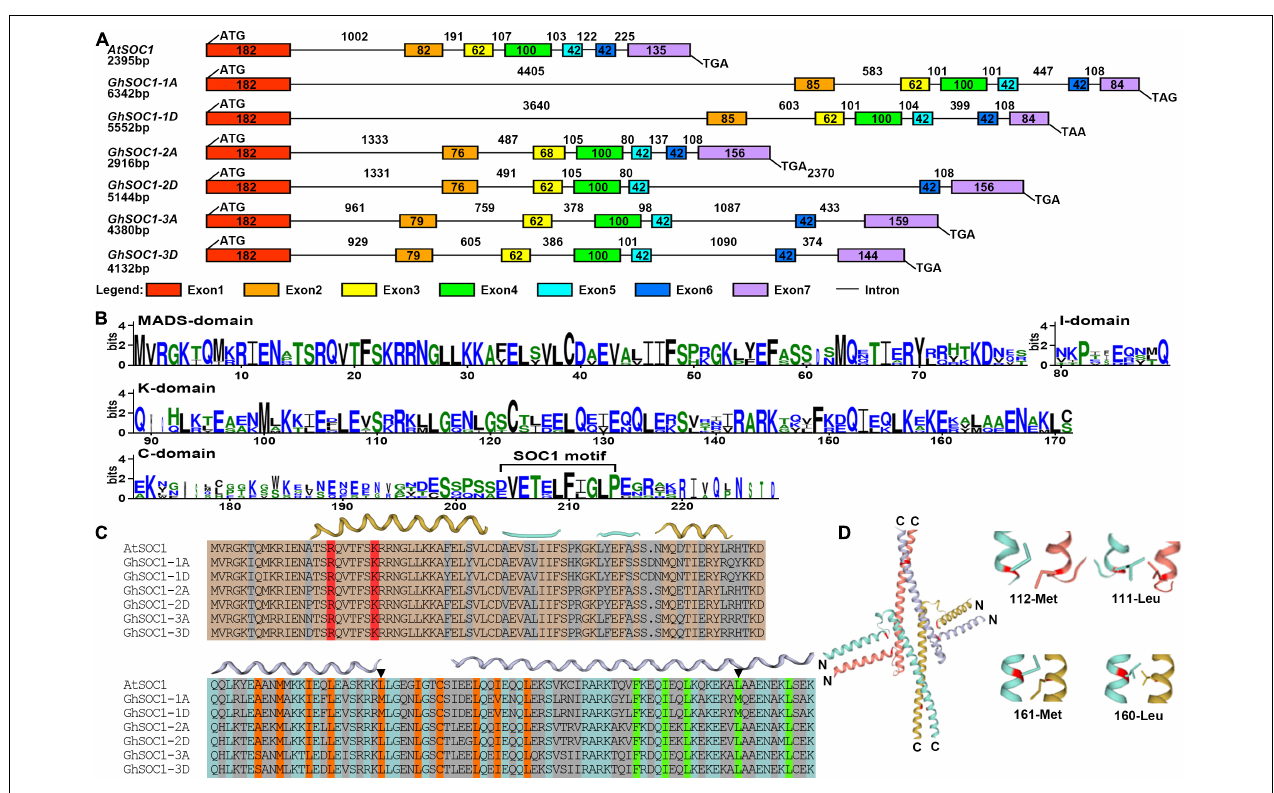
FIGURE 1 | Sequence analysis of GhSOC1s. (A) Gene structure of GhSOC1s . (B) Sequence conservation of the M, I, K, C domain of GhSOC1s. (C) Structure prediction of GhSOC1s. The interface of the MADS domain with DNA groove are marked in red. The orange color highlights the important residues for dimerization and the green color highlights the important residues for tetramerization. Triangles mark the varied Leucine residues. (D) 3-D structure of the K domain. The varied Leucine residues of GhSOC1-1 are highlighted in red. Close-up display the varied interacting residues depicted as sticks.